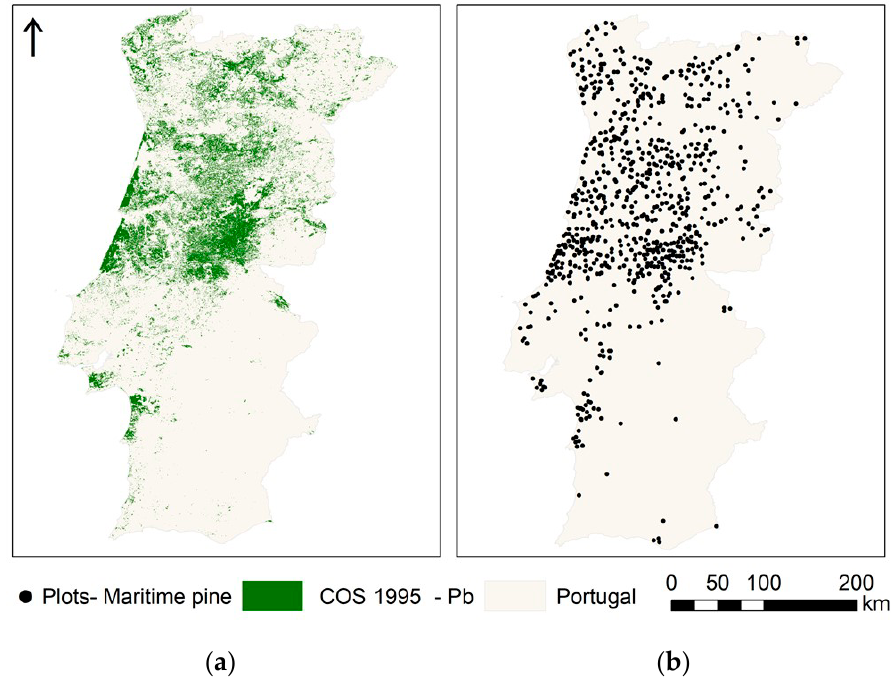
Figure 1. Maritime pine study area: ( a ) land cover map (COS 1995); and ( b ) forest inventory plots (1995) in pure Maritime pine stands ( n = 739).